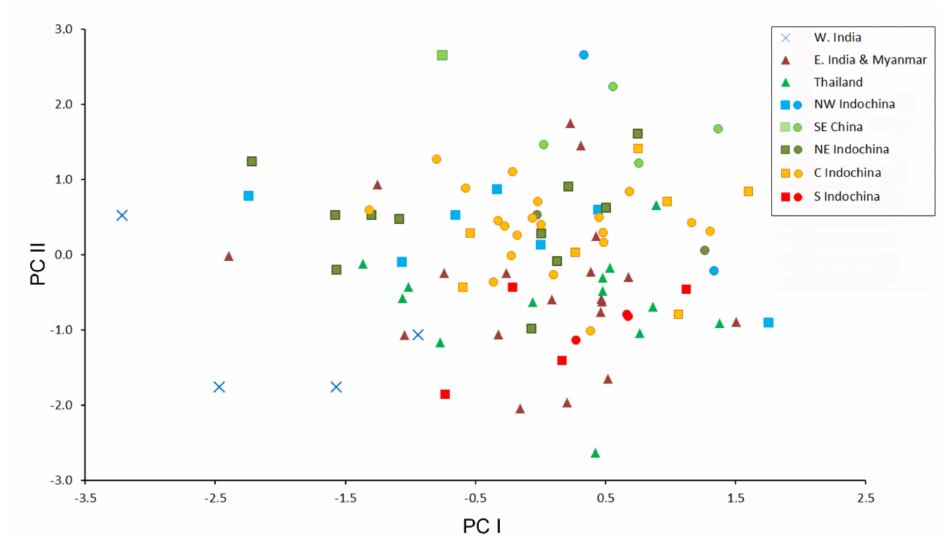
Figure 4. Bivariate scatter plot for the first two factors of a Principal Component analysis based on 18 cranial and dental measurements of 99 specimens of Hipposideros pomona s. lato. Specimens marked by closed circles were genotyped with at least one mitochondrial gene.